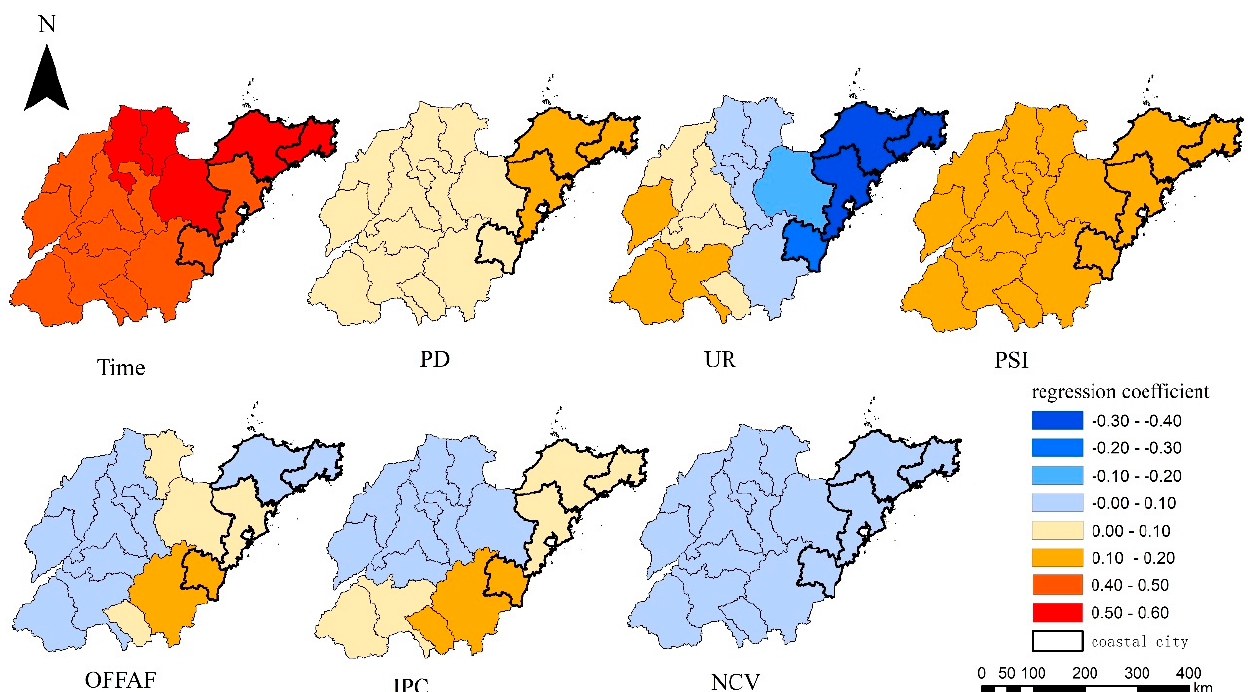
Figure 5. Distribution of MGWR regression coefficient.